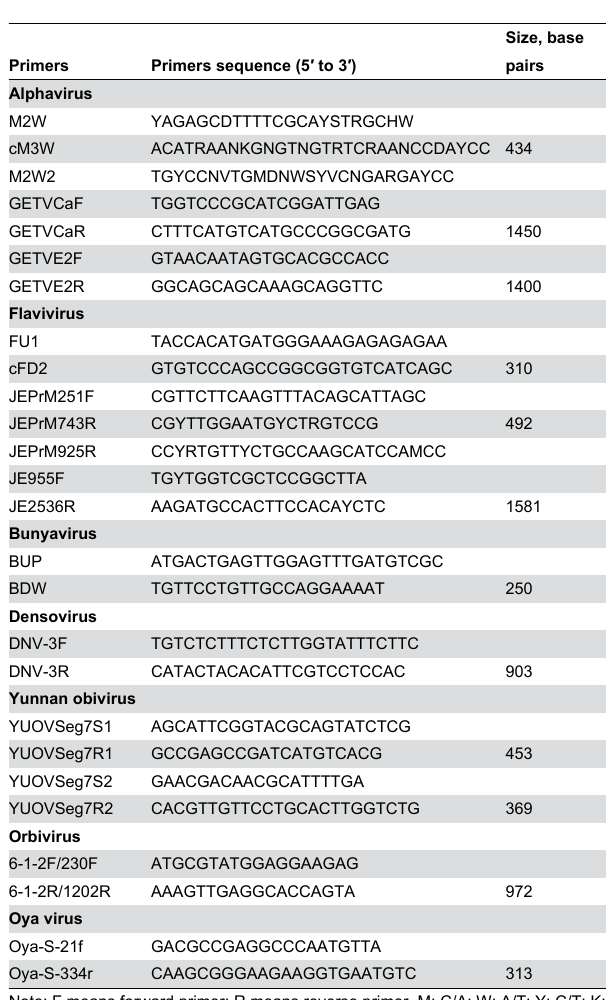
Table 2. Primers used to identify and sequence viruses isolated from mosquitoes in this